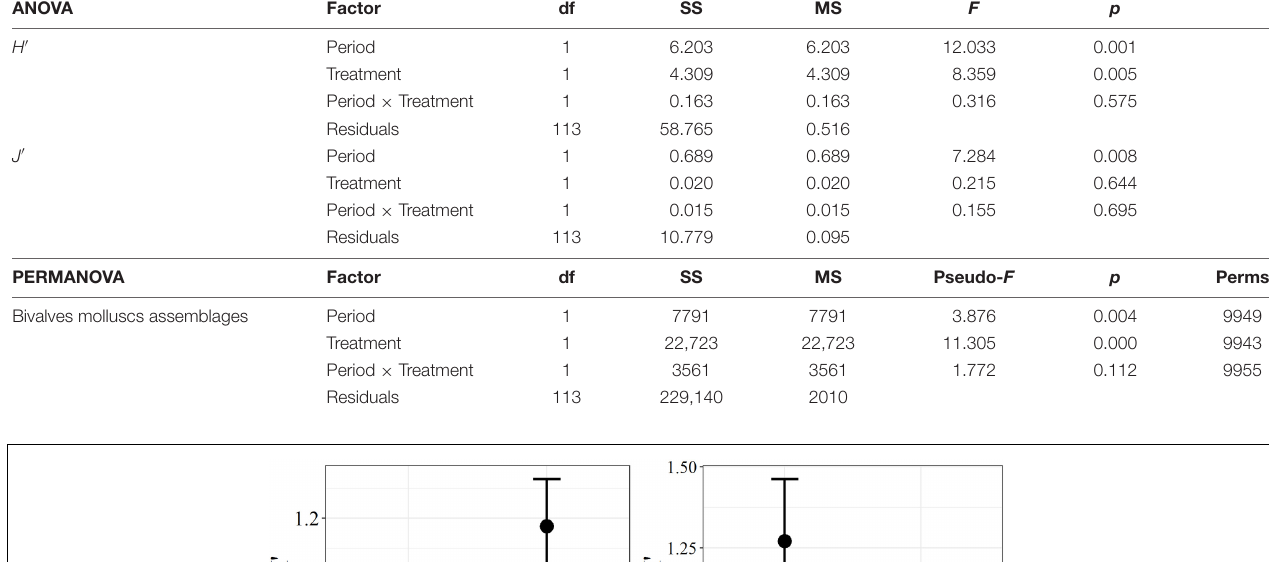
TABLE 3 | One-way ANOVA results of the two diversity indices H (cid:48) (Shannon–Weiner diversity index) and J (cid:48) (Pielou’s evenness) of the molluscs assemblages, and PERMANOVA result for the molluscs assemblages based on the Bray–Curtis similarity matrix of the two communities present in the two treatments (Impact and Control) and in the two periods (2017 and 2018).